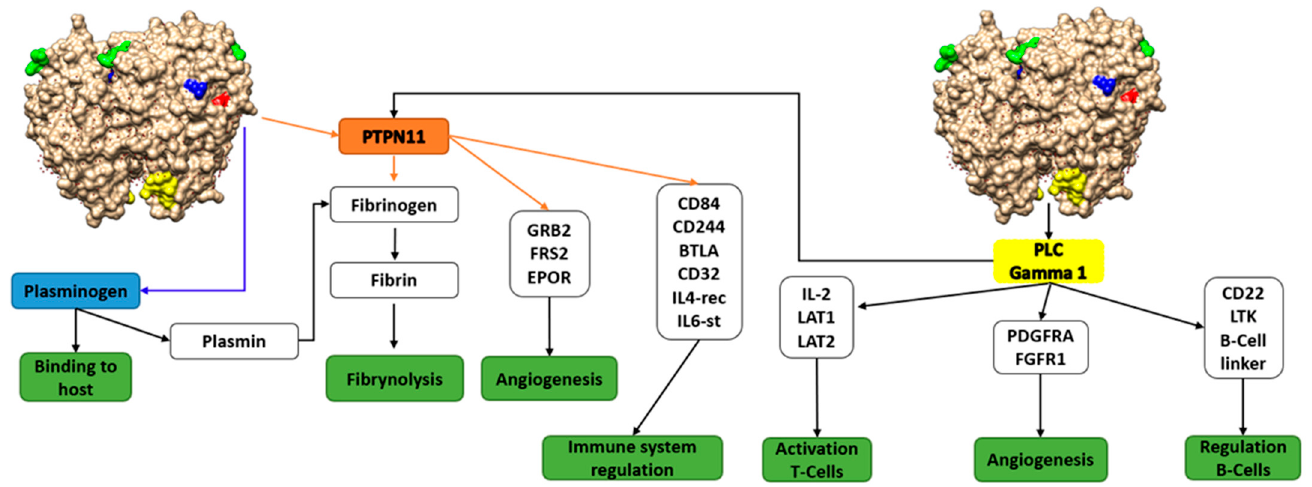
Figure 3. Interactions of the predicted virulence motifs. The motif colored in red interacts with PTPN11 and the one in yellow interacts with PLC gamma 1. As can be seen, both proteins are involved in tissue regeneration and immunomodulation. PTPN11 (protein tyrosine phosphatase non-receptor type 11); PLC gamma 1 (phospholipase C-gamma 1). Green and blue motifs are those experimentally found according to the bibliography.